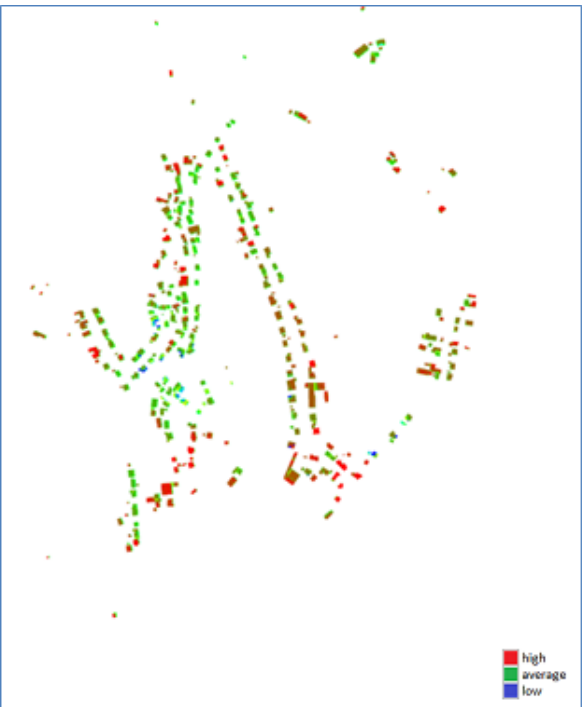
Figure 17 Finsterrot LOD 2 model with solar potential for only